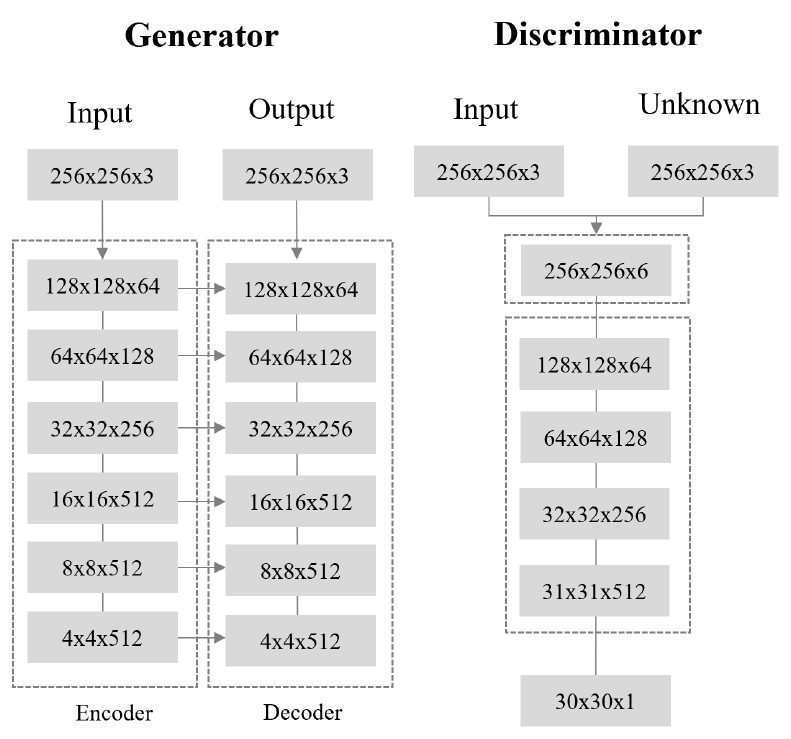
Figure 7. Proposed generator and discriminator architecture.